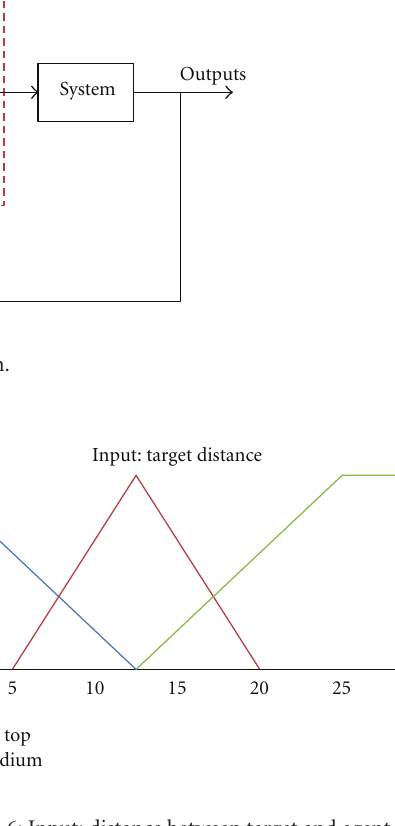
Figure 6: Input: distance between target and agent.